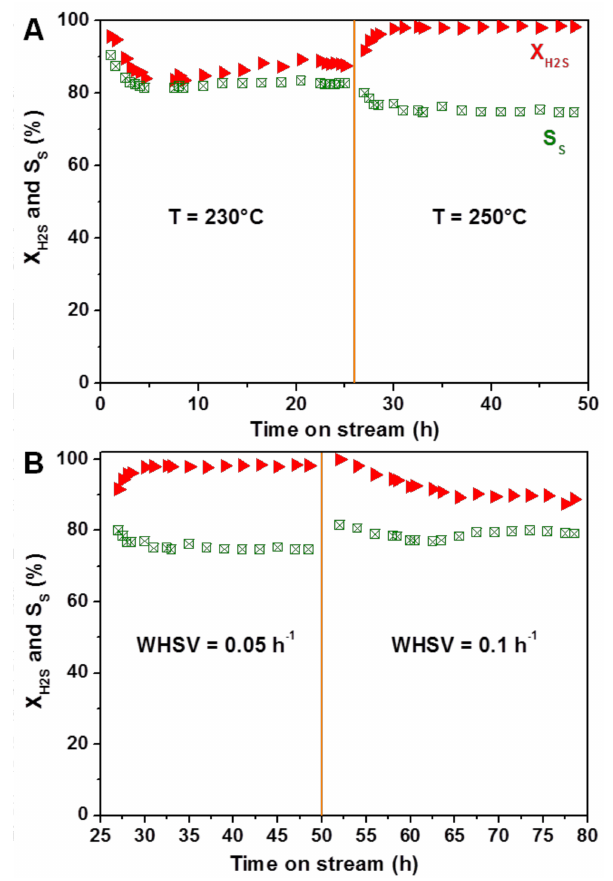
Figure 9. Desulfurization performance as a function of time on stream on the OGFs-16 catalyst. ( A ) Reaction conditions: [H 2 S] = 1 vol. %, [O 2 ] = 2.5 vol. %, [H 2 O] = 30 vol. %, Weight Hourly Space Velocity (WHSV) = 0.05 h − 1 ; ( B ) Reaction conditions: [H 2 S] = 1 vol. %, [O 2 ] = 2.5 vol. %, [H 2 O] = 30 vol.